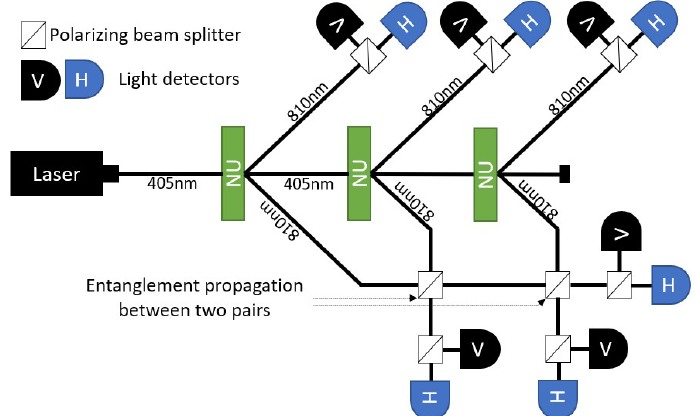
Figure 1. Experimental setup for six-photon entanglement. Firstly, two pairs of photons are generated by nonlinear units (NUs) in series. Following this, one photon from each pair reconnects with the remaining section of the system via the polarization beam splitter. From the reconnection points, entanglement propagates throughout the entire system, generating the GHZ